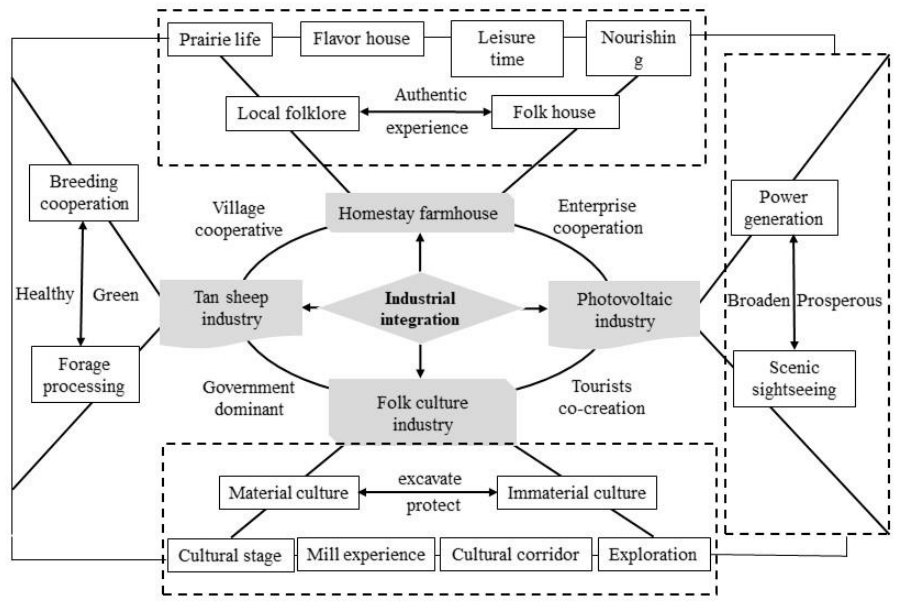
Figure 5. The photovoltaic industry drives integrated development mode in Changliudun village.